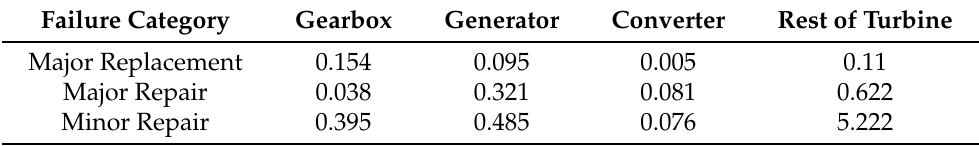
Table 3. Baseline failure rates [23].